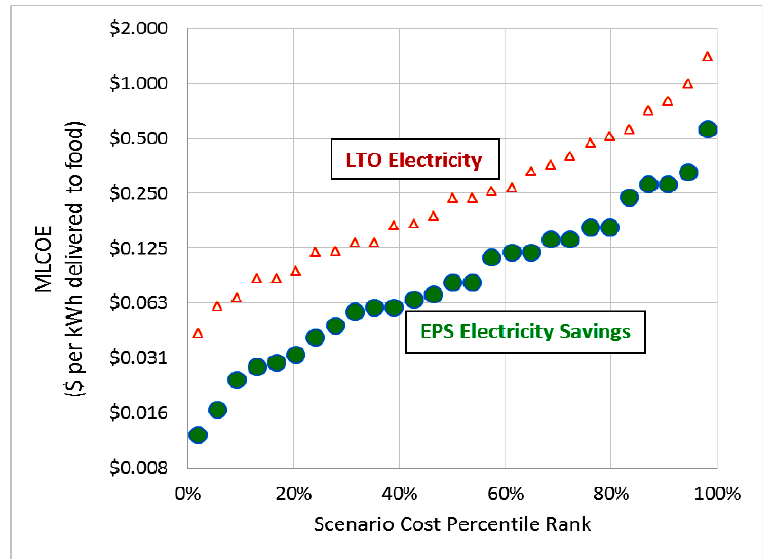
Figure 10. MLCOE distribution for EPC electricity savings in a DDS LTO SEC compared with the MLCOE distribution for regulated LTO electricity. The MLCOE of EPC electricity savings is approximately 1/3 of the cost of LTO-regulated electricity and is about 35% less costly than DDS electricity. The median EPC savings MLCOE is USD 0.08/kWh. Note that the vertical axis has logarithmic scaling.